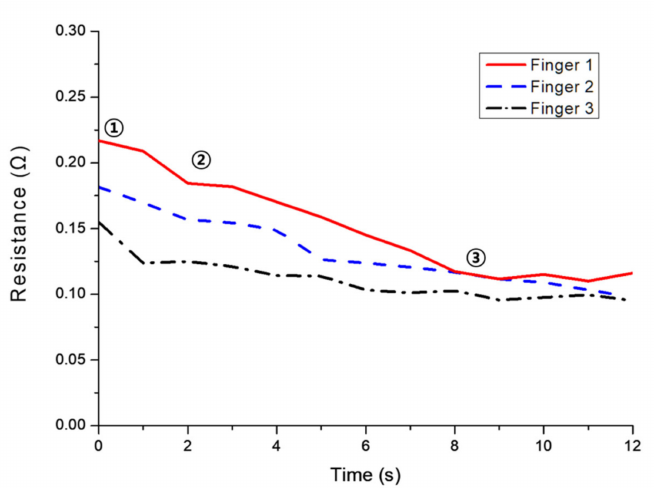
Figure 19. Variation in sensing resistance according to fingertip shape. Numbered timestamps correspond to the labeled images in Figure 20.